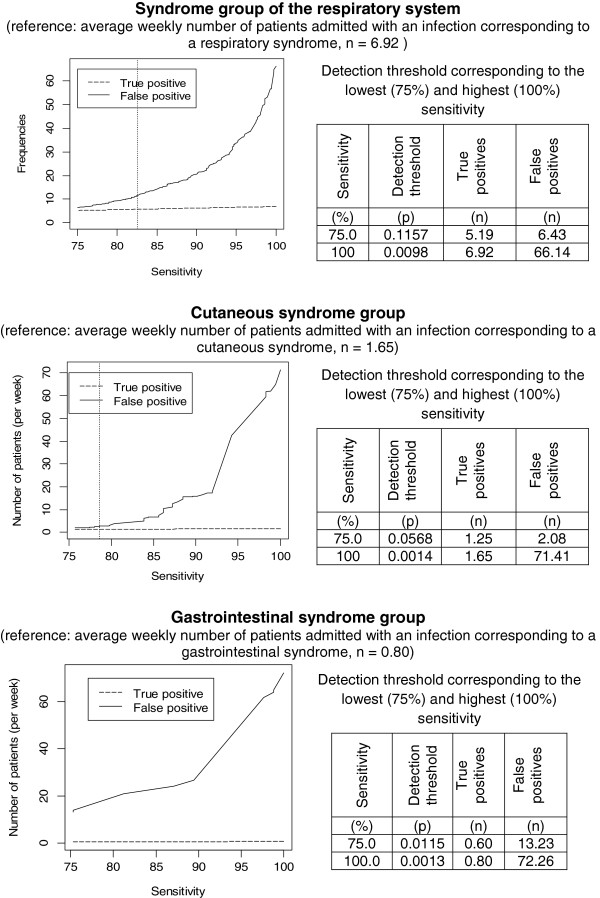
Variation in the number of true and false positives per week according to sensitivity in the training set. Numbers of true and false positives per week were calculated in the population studied (mean population per week=73.06; learning dataset). Tables show the values of optimal detection thresholds (vertical lines) and thresholds corresponding to 75% and 100% sensitivity.